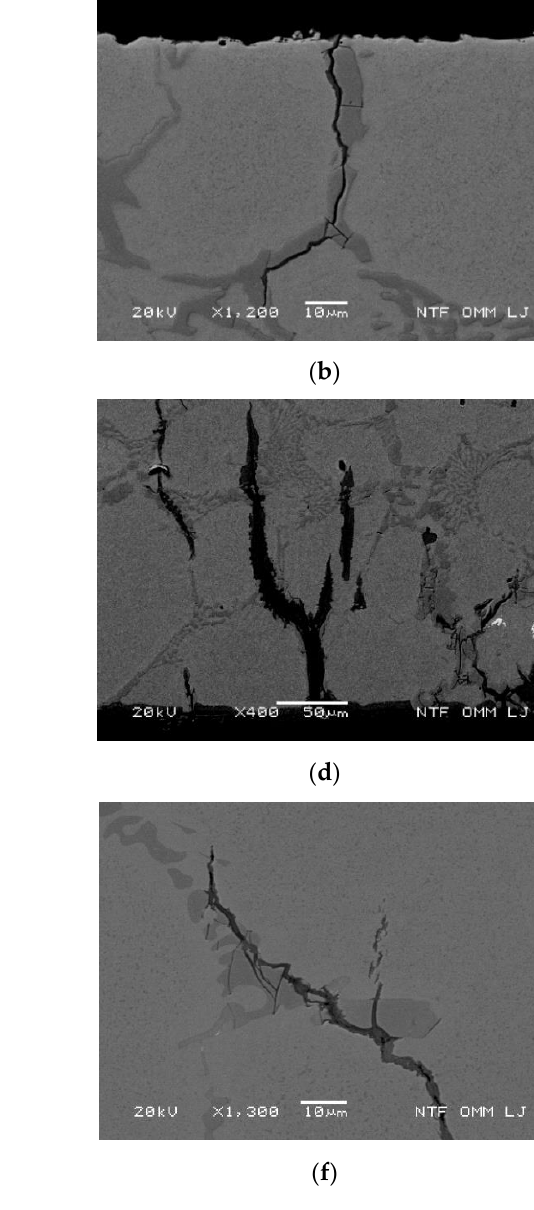
Figure 12. Secondary crack pathways and oxidation behavior; ( a ) using carbide / matrix interface after 1000 cycles at 500 ◦ C, ( b ) carbide / matrix crack pathway after 2500 cycles at 500 ◦ C, ( c ) deviation of oxidation direction after 1000 cycles at 700 ◦ C from carbide orientation to perpendicular direction in the matrix, ( d ) deviation of oxidation direction after 2500 cycles at 700 ◦ C, ( e ) change from carbide pathway to perpendicular direction in the matrix and detail of internal cracks in carbide cluster before crack tip of the primary crack and ( f ) crack branching from carbide pathway to matrix pathway in the perpendicular direction to the cooled surface.